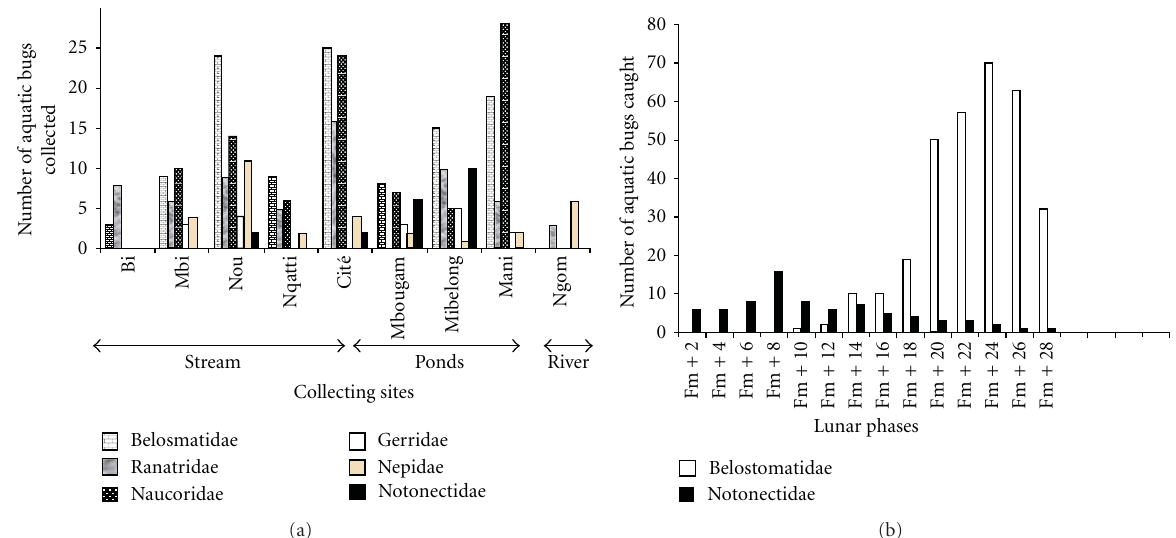
Figure 2: (a) Aquatic bugs per family and collecting water bodies in the aquatic environment. (b) Aquatic bugs caught in a light traps per families according to lunar phases. Table 1: Identification of water bugs collected directly in aquatic environment and indirectly by light trap. Category Family Sub family Genus Direct collection Indirect